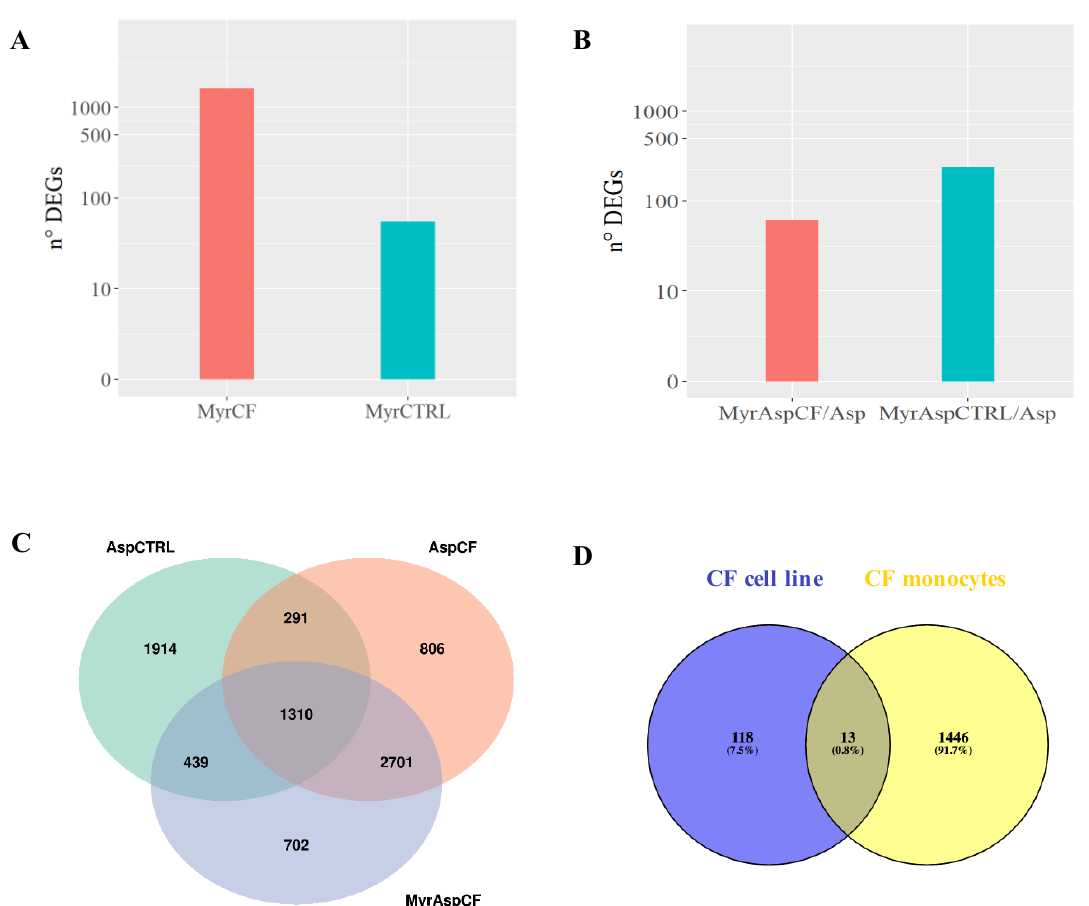
Figure 5. E ff ect of myriocin on CF and CTRL cells in infected and infection-free environments. ( A ) MyrCF indicates DEGs between Myr-treated CF cells and untreated CF cells; MyrCTRL indicates DEGs between treated CTRL cells and untreated CTRL cells; ( B ) MyrAspCF / Asp indicates DEGs between Myr-treated infected CF cells and untreated infected CF cells; MyrAspCTRL / Asp indicates DEGs between Myr-treated infected CTRL cells and untreated infected CTRL cells. ( C ) Venn diagram of CRTL and CF cells in response to infection (AspCTRL and AspCF) and infected CF cells in response to treatment (MyrAspCF). MyrAspCF: DEGs between Myr-treated infected cells and uninfected untreated CF cells. ( D ) Venn diagram of CF cells and CF monocytes: DEGs between Myr-treated infected CF cells and Myr-treated infected monocytes from CF